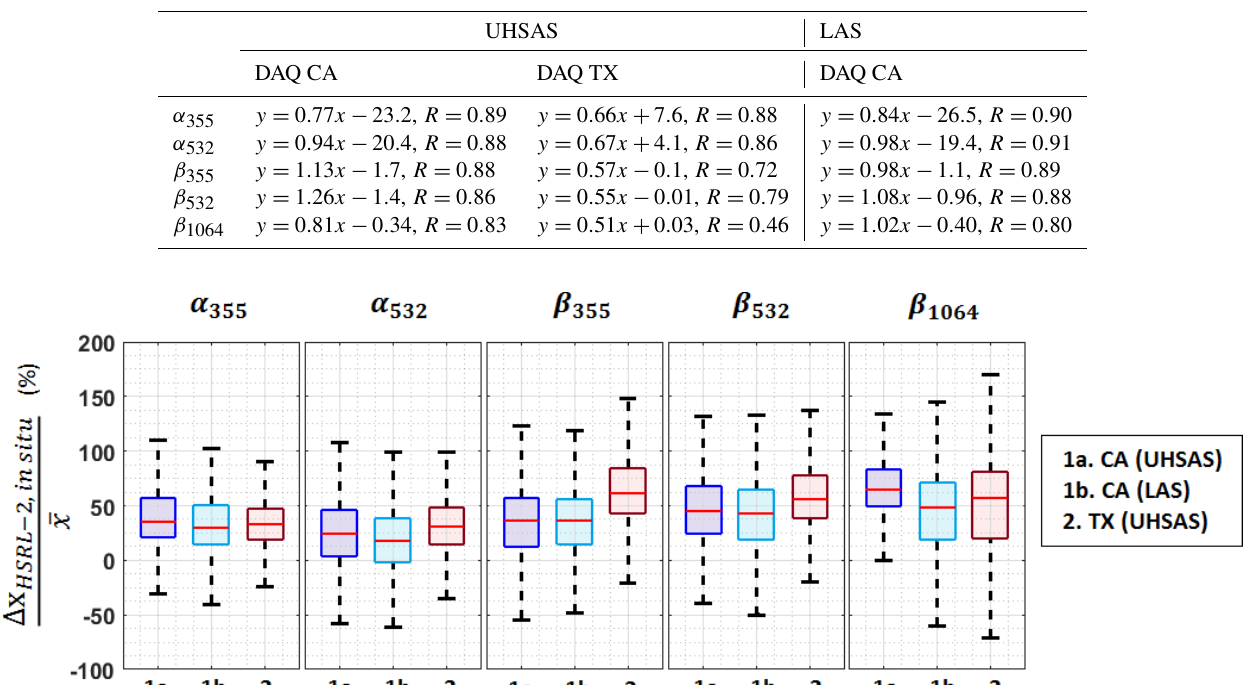
Table 1. Parameters of bisector linear regression fit between the HSRL-2 measurements ( x ) and the reconstructed version of 3 β + 2 α ( y : from in situ measurements). The columns under UHSAS contain the parameters from the linear regressions depicted as red dashed lines in Fig. 8. The column under LAS contains the parameters from the linear regressions obtained when the reconstructed version ( y ) is calculated using LAS measurements instead of UHSAS measurements (not shown, see text). R refers to the Pearson’s correlation coefficient. Extinction